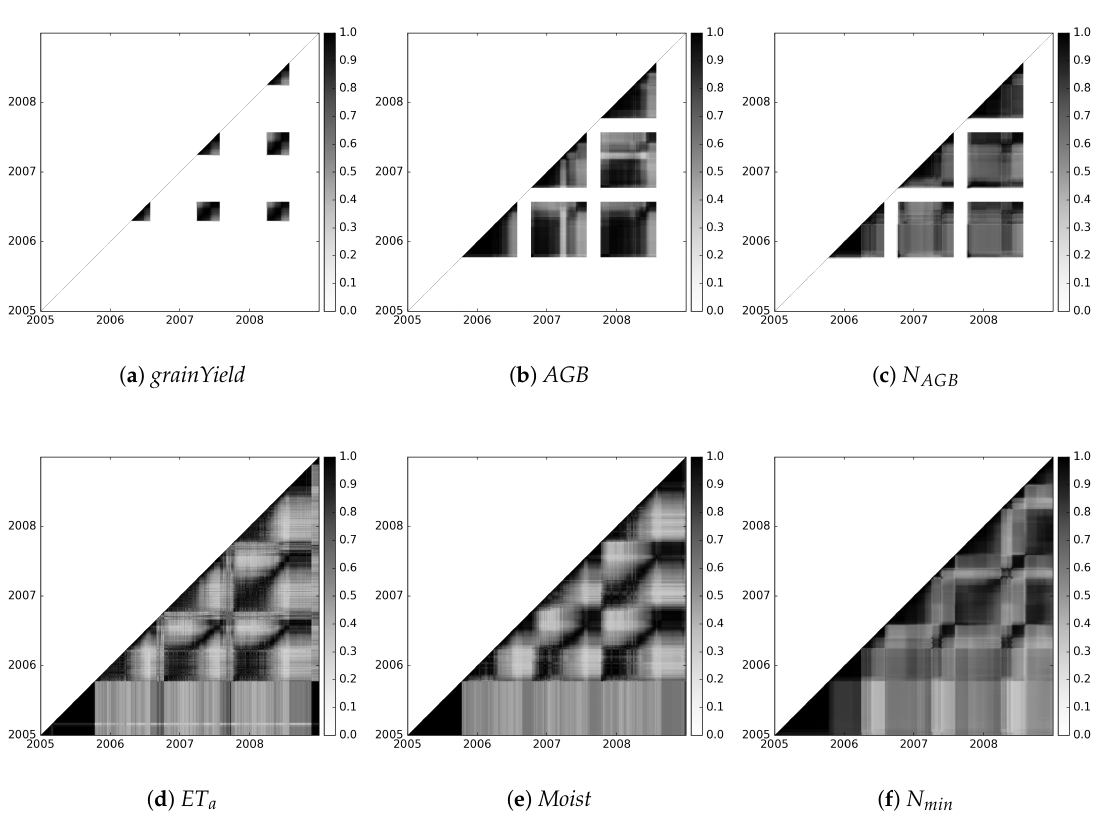
Figure 6. TDCCs of parameter rankings based on the daily main effects for different simulation days, averaged over all study sties. A higher TDCC indicates greater similarity of the parameter rankings. The dark areas indicate periods during which the parameter rankings were similar for different simulation times.